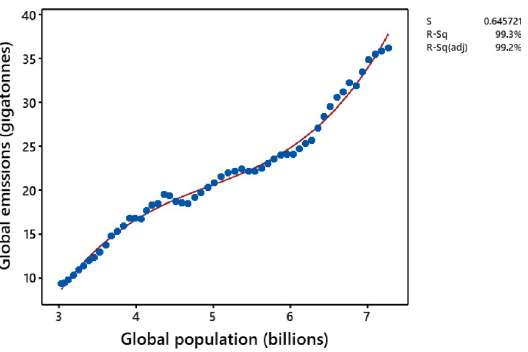
Fig 1. The cubic relationship between global CO 2 emissions and world human population size (1960–2014; Y = 59.92 X– 11.4 X 2 + 0.77 X 3 –89.27; R 2adj = 0.992; N = 55). Line = fitted curve, dots =